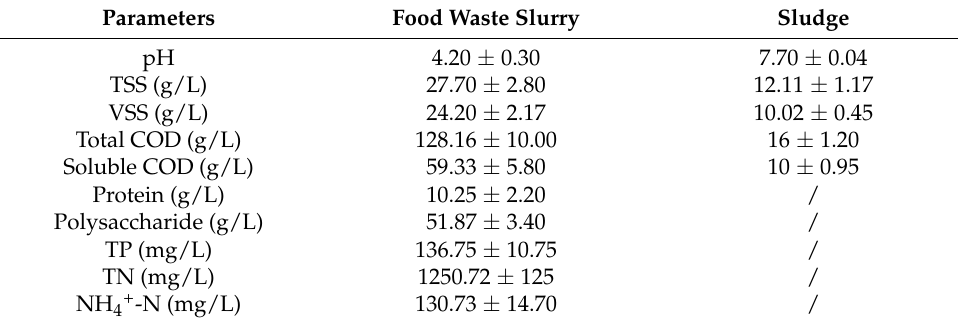
Table 1. Characteristics of food waste slurry and